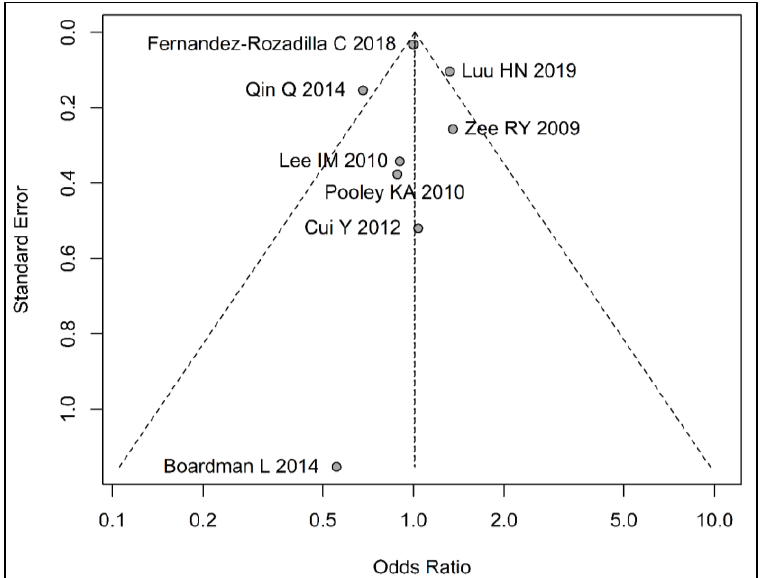
Figure 3. Funnel plot assessing potential publication bias of included studies (n = 8) in meta-analysis of telomere length (comparing longest quartile vs. shortest) and colorectal cancer risk. (References: